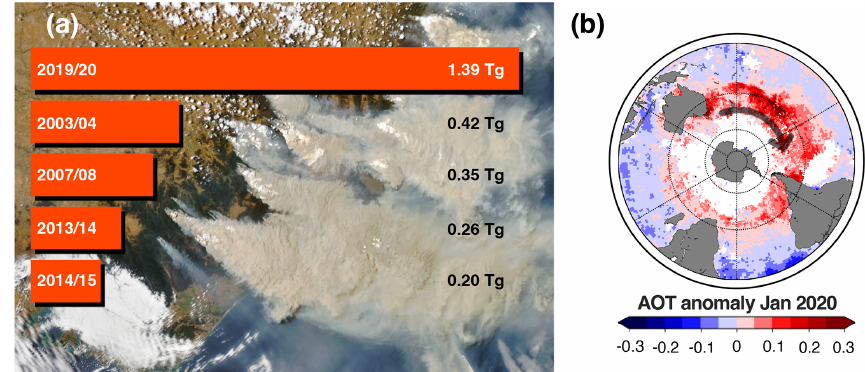
Figure 1. (a) Biomass burning plumes in the Canberra region of southeastern Australia as seen from NASA’s Aqua satellite on 4 Jan- uary 2020 (NASA Earth Observatory image by Joshua Stevens, using MODIS data from NASA EOSDIS/LANCE and GIBS/Worldview, https://earthobservatory.nasa.gov, last access: 1 April 2020). Overlaid is a ranking of carbon aerosol emissions accumulated for the annual southeastern Australian bushfire seasons (September–March) based on Global Fire Assimilation System (GFAS) data (Kaiser et al., 2012). (b) Anomaly in monthly mean aerosol optical thickness (AOT) at 630nm for January 2020 (by remapping to 1 ◦ × 1 ◦ , pixels with less than 300 valid retrievals at 0.1 ◦ original resolution are excluded, see further details in Sect. 2.3) compared to the long-term January mean (1982– 2019), as observed by NOAA’s AVHRR instrument (Zhao and NOAA CDR Program, 2017) (missing data shown in white, continents in